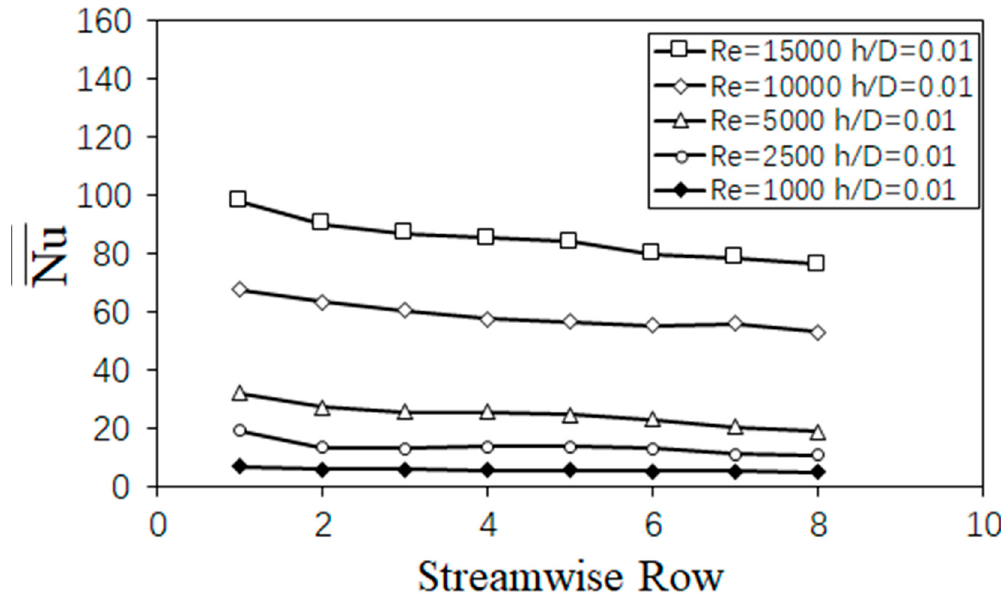
Figure 13. Spatially averaged Nusselt numbers as dependent upon streamwise row location, for different Re j , for micro cooling units height of 0.01 D.